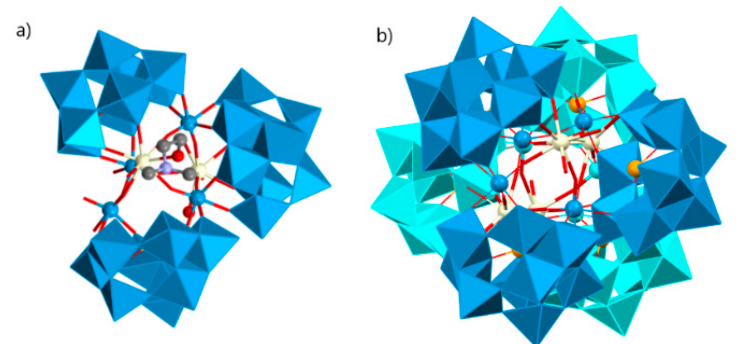
Figure 3. ( a ) Trimeric [Ce 2 (H 2 O) 6 (DMEA)W 4 O 9 ( α -SeW 9 O 33 ) 3 ] cluster. ( b ) Hexameric [Ce 2 W 4 O 9 (H 2 O) 7 ( α -SeW 9 O 33 ) 3 ] 2 polyoxoanion structure [141].